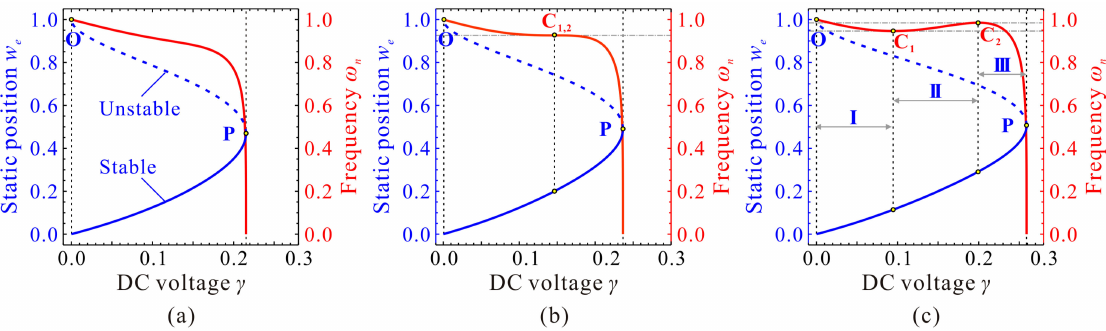
Figure 5. Static position w e and fundamental frequency ω n for different cubic stiffness α